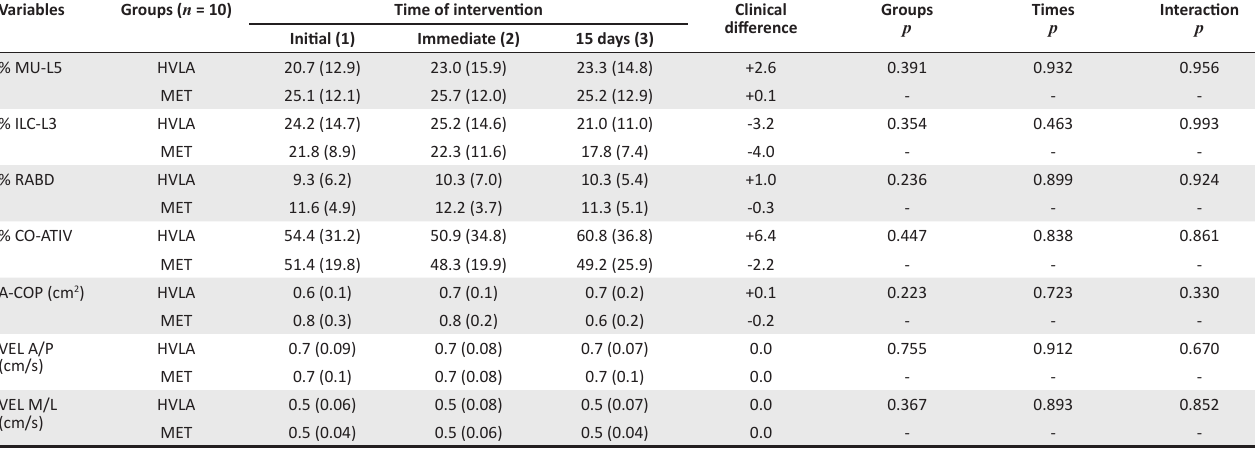
TABLE 2: Changes in trunk neuromuscular activation and postural control during balance bipodal in standing task without external load. Variables Groups ( n = 10)